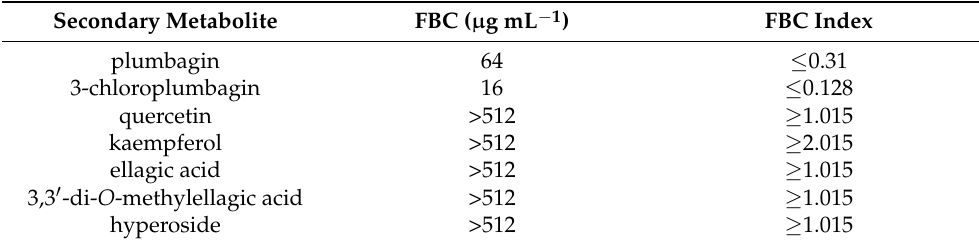
Table 6. Antimicrobial potential of selected secondary metabolites from Dionaea muscipula in combi- nation with silver nanoparticles towards Pseudomonas aeruginosa ATCC